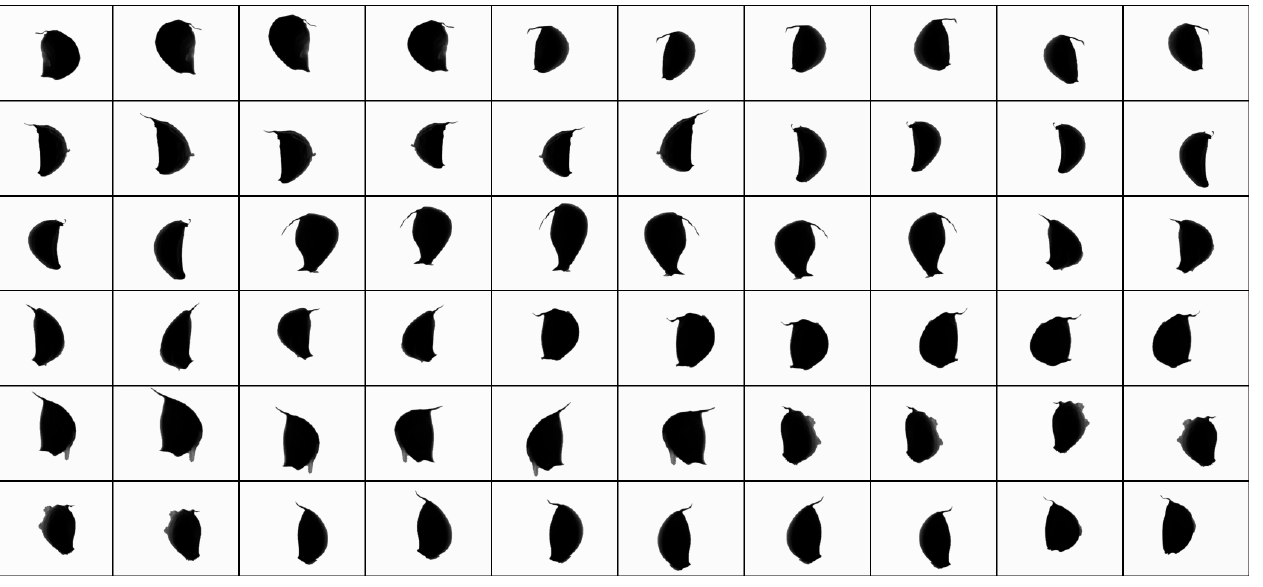
Figure 6. Stretching, shearing, and translation.